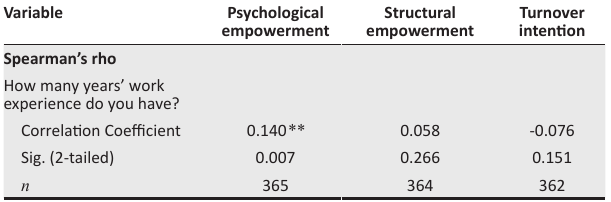
TABLE 5: Spearman’s rank correlation coefficient of tenure on structural empowerment, psychological empowerment and turnover intention. Variable